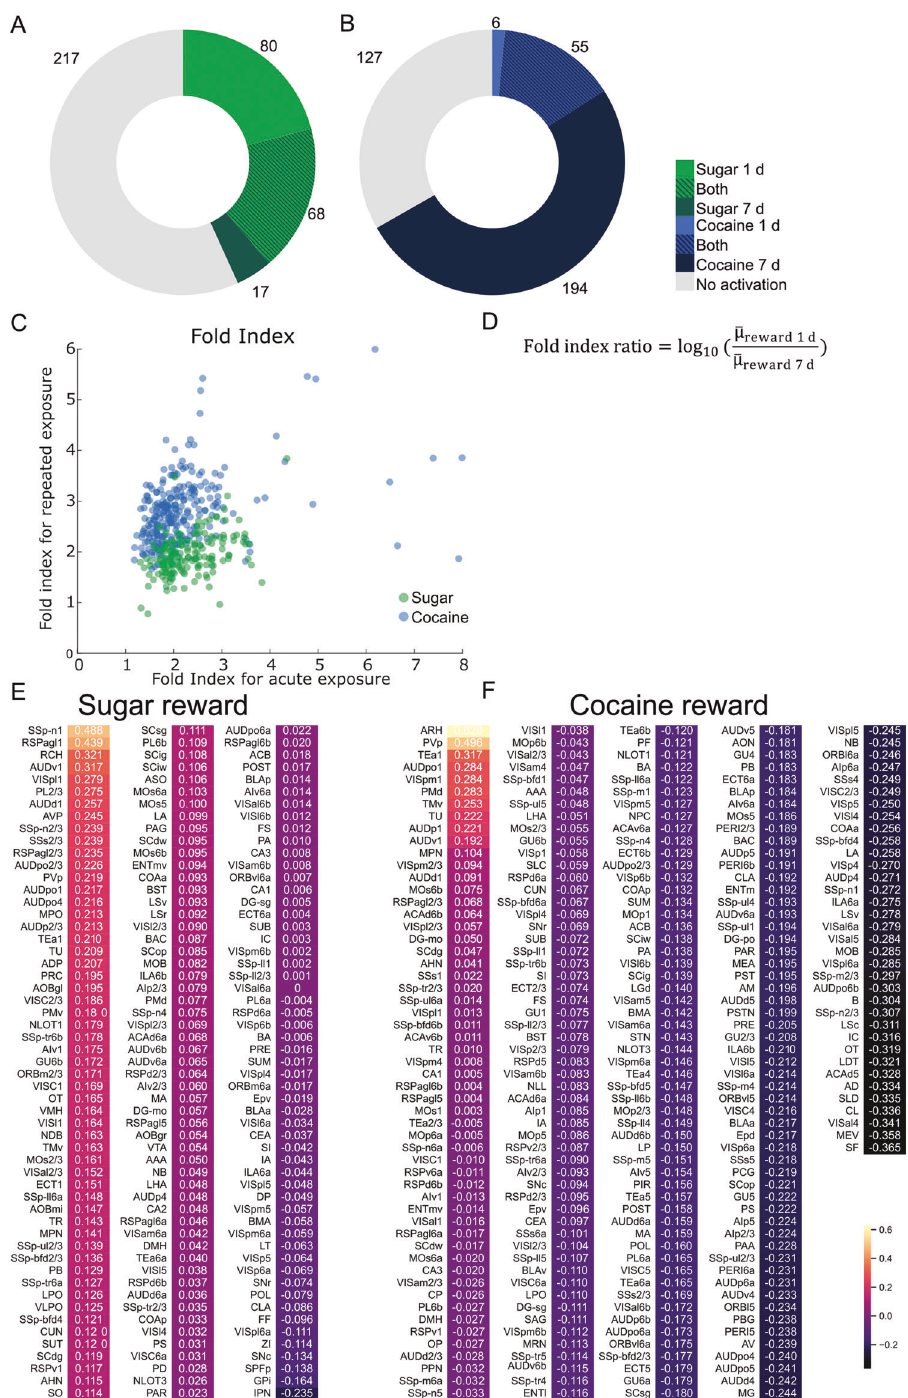
Fig. 3 c-Fos expression in the brain after acute and prolonged exposure to reward. A , B Number of structures with elevated c-Fos level after natural ( A ) or pharmacological reward ( B ) treatment. C Graph shows fold indices for structures after either acute or prolonged exposure to either natural (green) or pharmacological (blue) reward exposure. D Fold index ratio equation used to compare effects of acute and prolonged reward exposure. E , F Individual fold indexes ratios for natural ( E ) and pharmacological ( F ) rewards. Fold index ratios were calculated for structures, which compared to control groups had a p -value < 0.1 either for 1 day or 7 days of reward treatment. For each structure p -value was calculated. First, a generalized linear model (GLM) was calculated. For each GLM a Dunnett ’ s test was performed. Finally, due to a large number of structures a Benjamin-Hochberg false discovery rate correction was performed on p -values with a 0.1 cut-off. N Water = 7, N Sugar 1 d = 5, N Sugar 7 d = 7, N Saline = 7, N Cocaine 1 d = 6, N Cocaine 7 d =